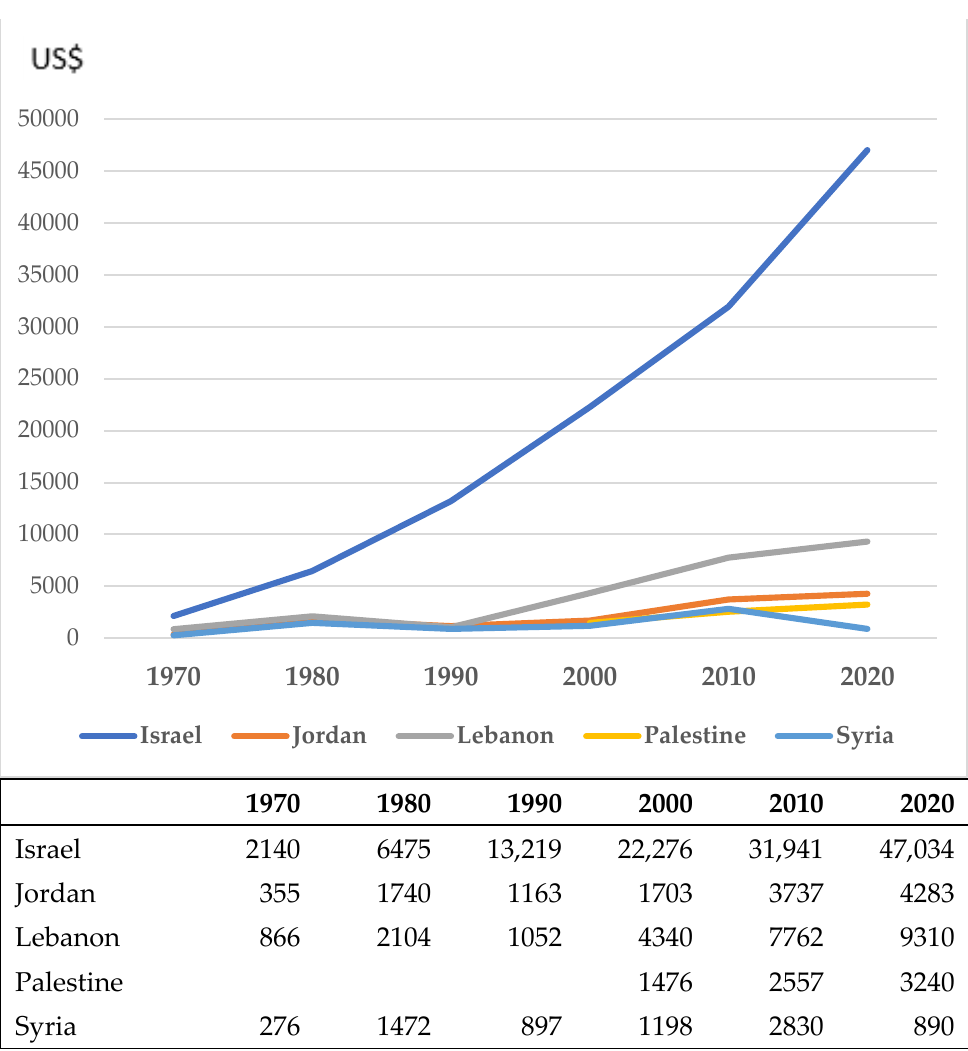
Figure 4. Gross Domestic Product (GDP) per capita at current prices — US dollars. Sources: [30,31].